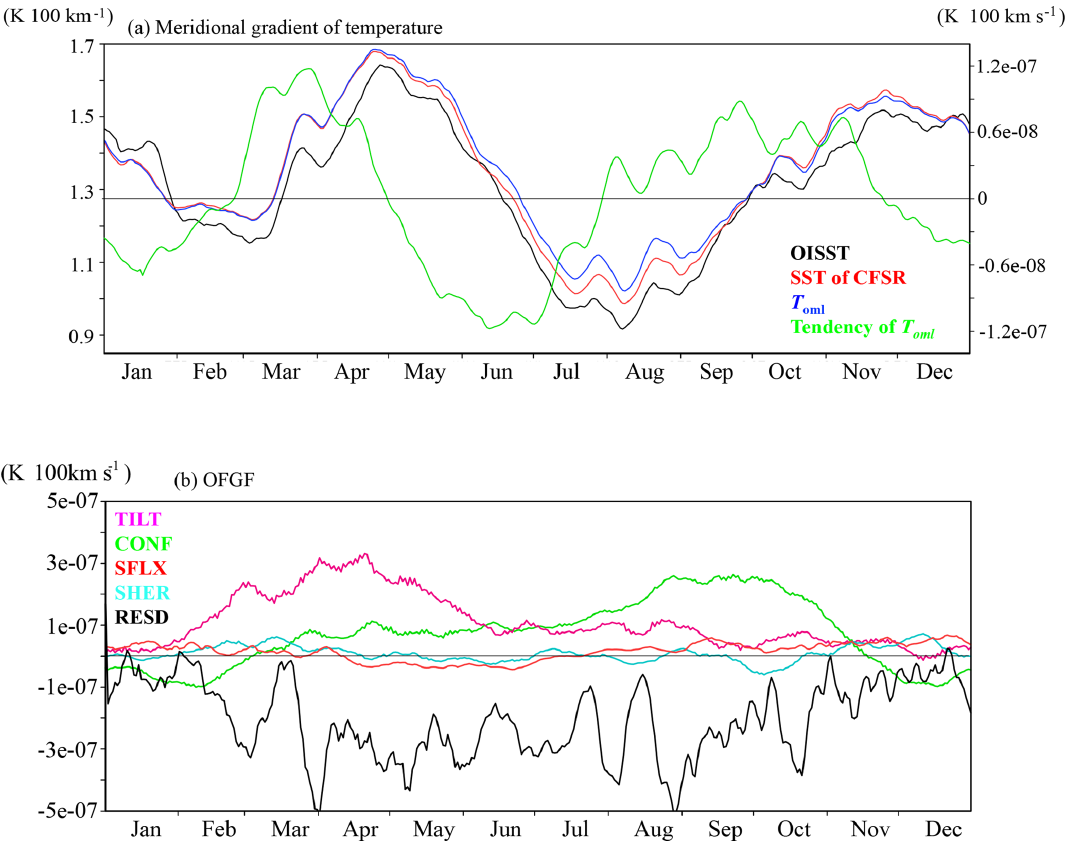
Figure 5. Box-mean (17–15 ◦ S and 10–12 ◦ E) time series of (a) meridional gradient of temperature (black: OISST, red: SST of CFSR, and blue: OML-temperature of CFSR) and (b) TILT (magenta), CONF (green), SHER (cyan), SFLX (red), and RESD (black). Eleven-day running means are shown for all time